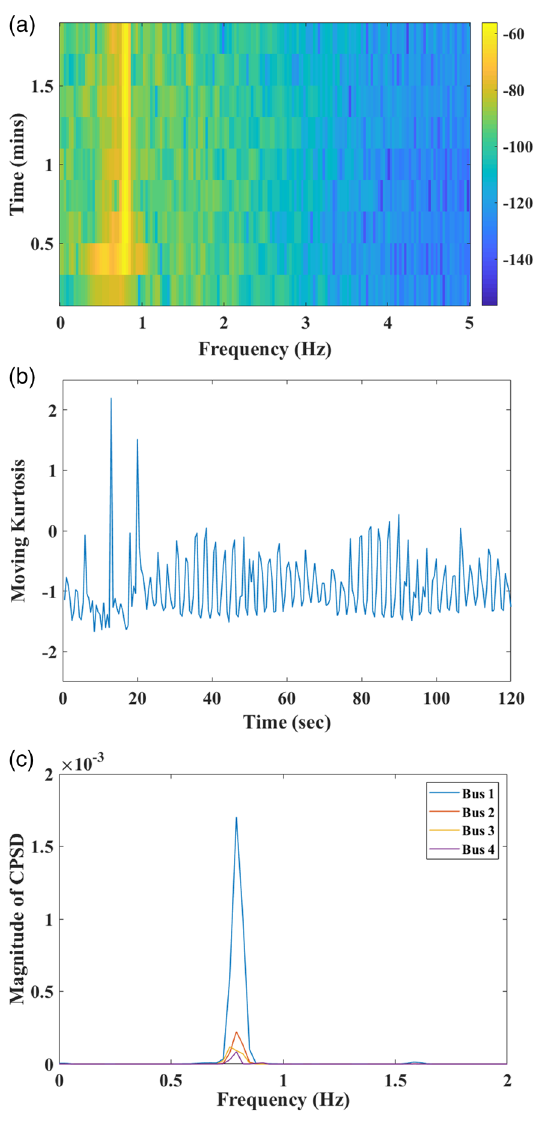
Fig. 5 a PSD of the selected DMAP. b Excess Kurtosis. c Magnitude of CPSD between the selected DMAP and raw PMU data from different buses associated with generation sources